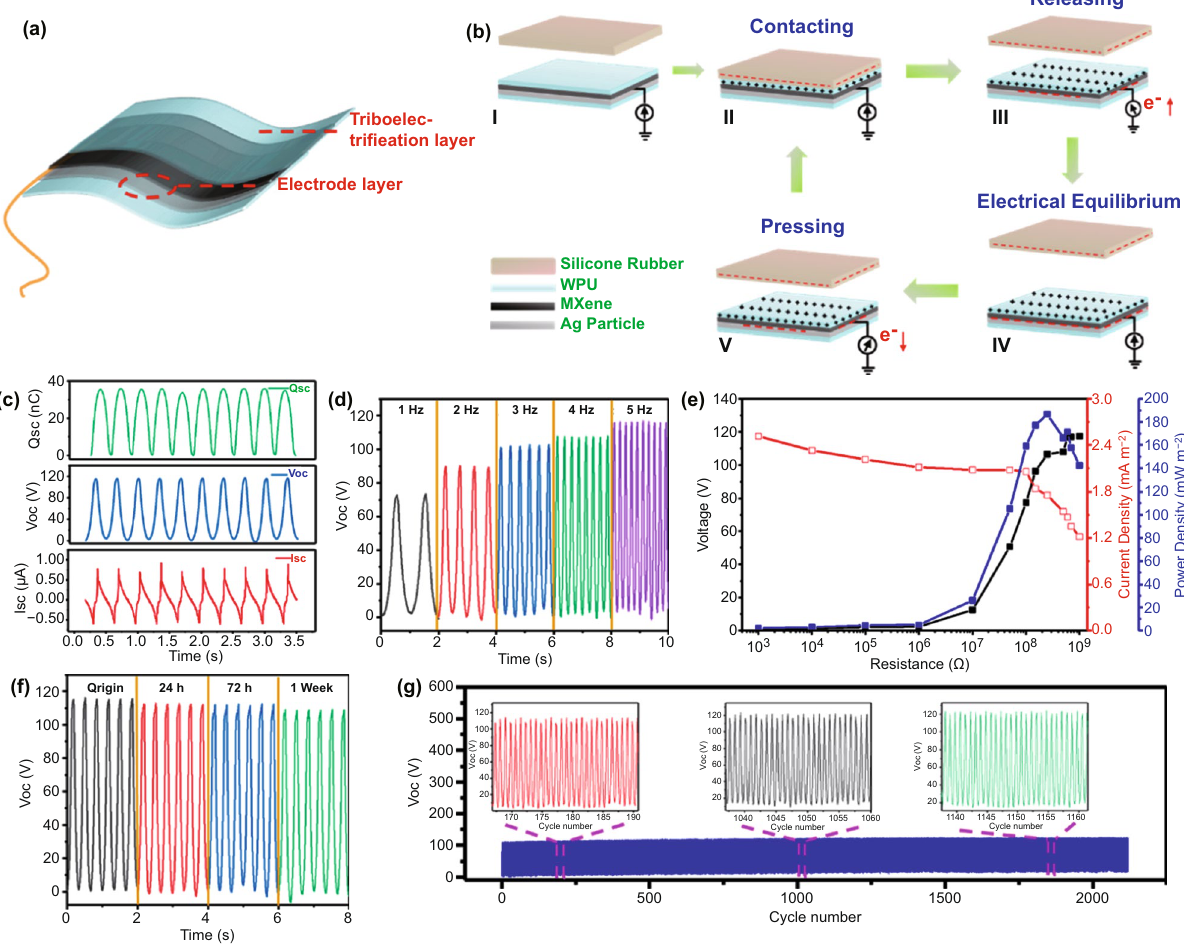
Fig. 3 a EHFs-STENG and b its working mechanism diagram. c The corresponding V OC , I SC , and Q SC of the STENG. d V OC of the STENG with various frequencies (fixed pressure 10 N). e The output performance under the resistance of 1 kΩ–1GΩ. f V OC of STENG in a wet environ- ment within one week. g Long-term stability test of the